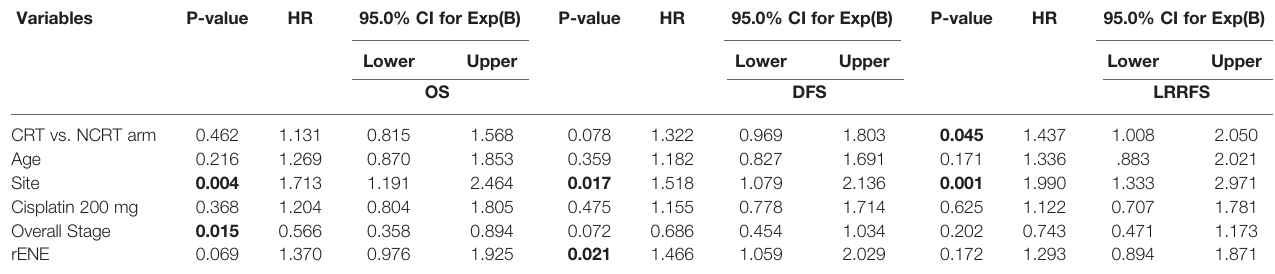
TABLE 4 | Multivariate analysis for OS, DFS, and LRRFS.